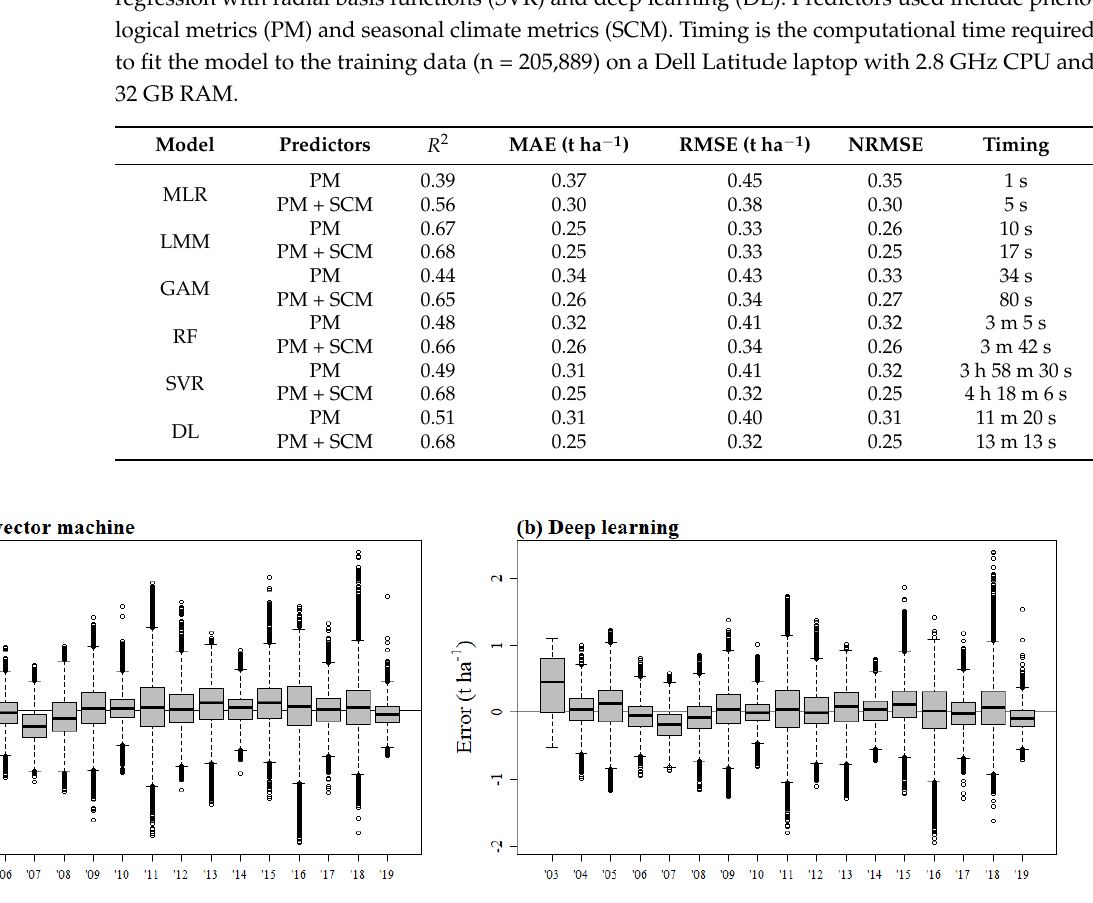
Figure 5. Boxplots showing error distributions (observed − predicted yield) for each year using the two machine learning models identified as equally optimal: ( a ) Support vector machines with radial basis functions and ( b ) deep learning.